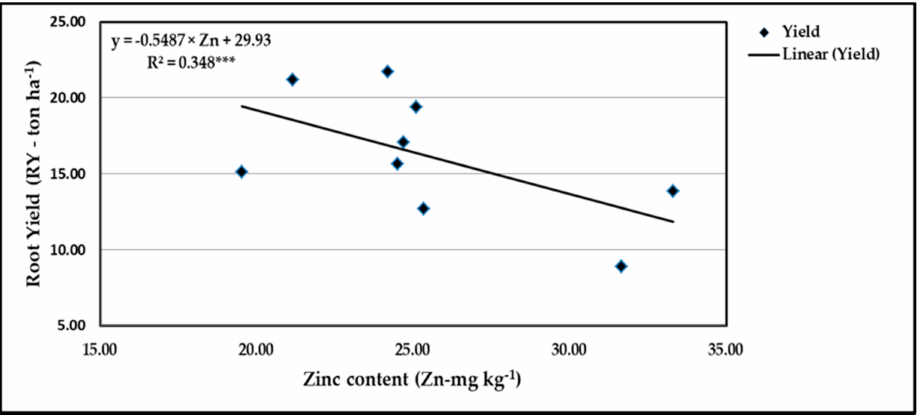
Figure 17. Contribution of Zn content to the quadratic response of stressed sweet potato to different levels of ascorbic acid and zinc oxide nanoparticles in the 2019 season. *** indicates differences at p ≤ 0.001 probability level.